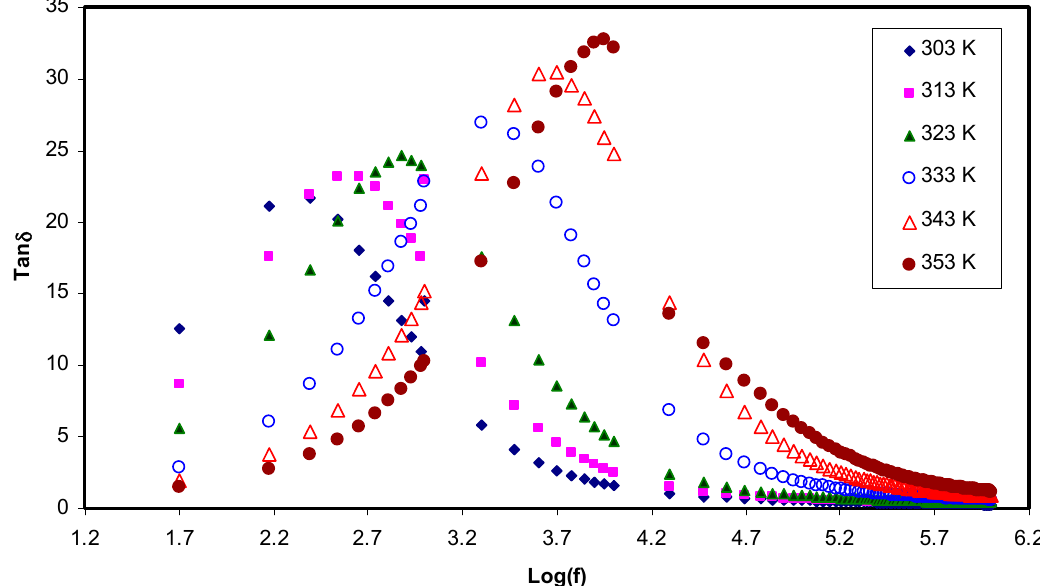
Figure 12. Tan δ as a function of the logarithm of frequency (f) at different temperatures. Tan δ increases with increasing frequency till reaching a maximum value at different temperatures and followed by it decreases with an increase in frequency.